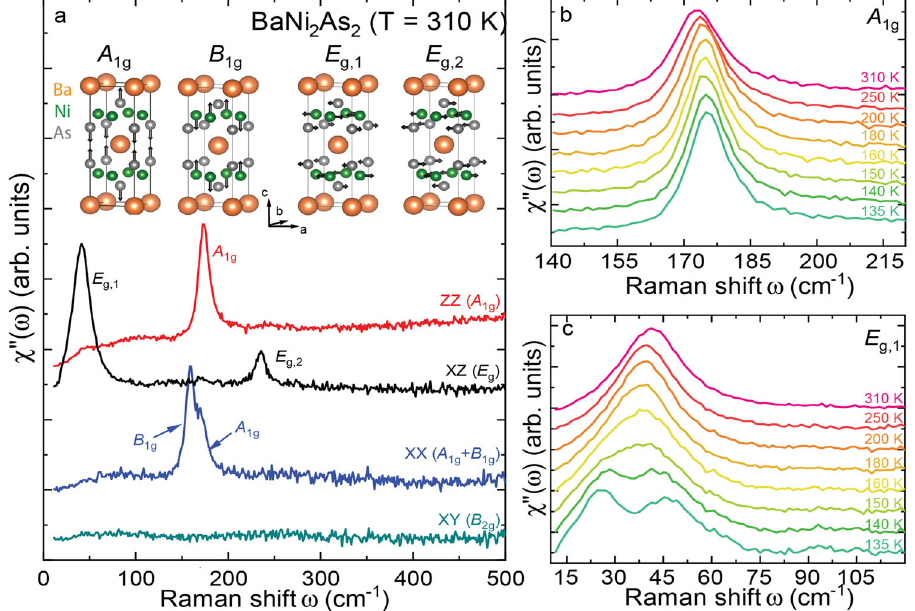
Fig.1|RamanscatteringfromBaNi 2 As 2 .a RamanactivephononsofBaNi 2 As 2 ,and roomtemperatureRamanspectraobtainedinthedifferentincomingandscattered